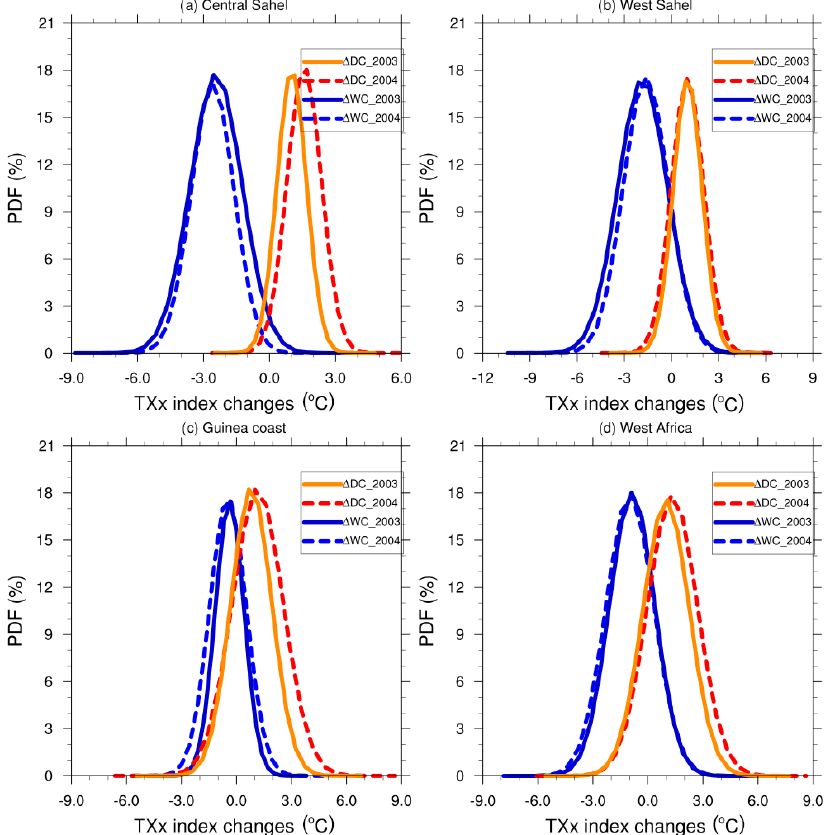
Figure 15. PDF distributions (%) of changes in the maximum value of the daily maximum temperature (TXx index, in ◦ C) for JJAS 2003 and JJAS 2004 over the (a) Central Sahel, (b) West Sahel, (c) Guinea coast and (d) West Africa derived from dry ( (cid:49) DC) and wet ( (cid:49) WC) experiments compared with the control